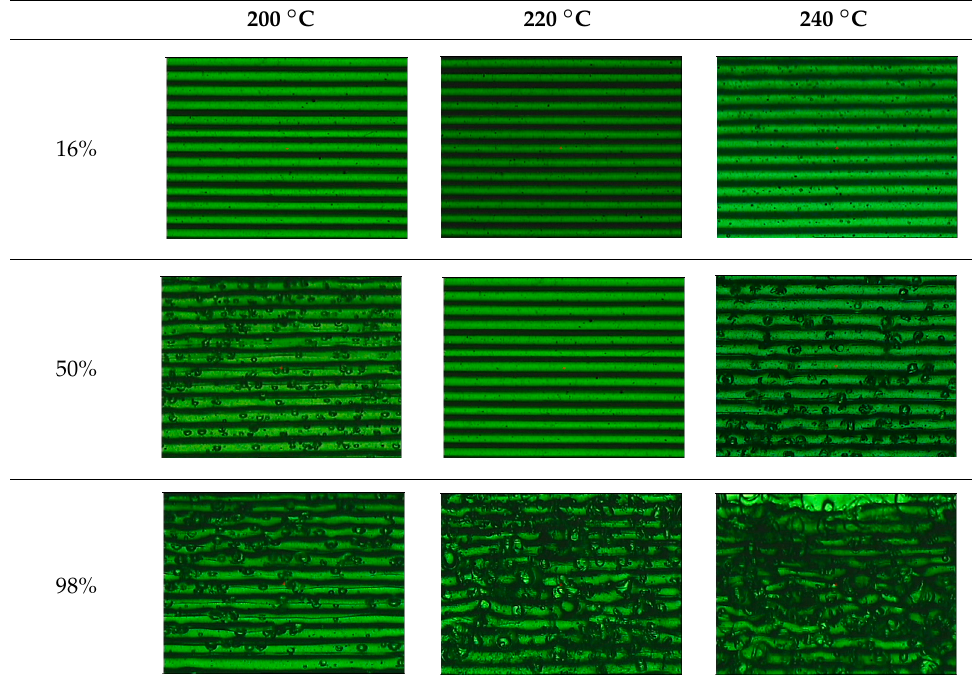
Figure 5. Evolution of roughness average (Ra) as a function of temperature and different pigments. Table 3. Influence of storage conditions and operating temperature on the surface finish. Table 3. Influence of storage conditions and operating temperature on the surface Table 3. Influence of storage conditions and operating temperature on the surface finish. Table 3. Influence of storage conditions and operating temperature on the surface finish. Table 3. Influence of storage conditions and operating temperature on the surface finish. Table 3. Influence of storage conditions and operating temperature on the surface finish. Table 3. Influence of storage conditions and operating temperature on the surface finish. Table 3. Influence of storage conditions and operating temperature on the surface finish. Table 3. Influence of storage conditions and operating temperature on the surface finish.